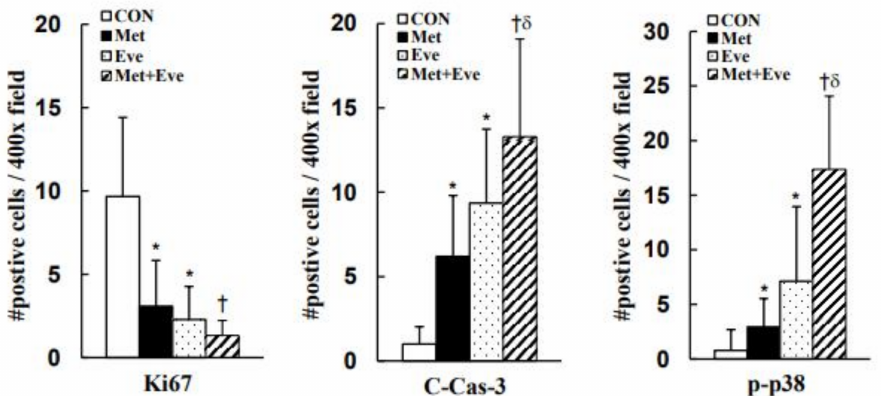
Figure 8. Metformin and everolimus inhibited tumor growth of C33A xenografts in vivo. BALB/c nude mice were subcutaneously injected with C33A cells (1 × 10 7 cells). When the subcutaneous tumor volume reached ~200 mm 3 , metformin (150 mg/kg), everolimus (5 mg/kg), or vehicle control alone (10% DMSO) was intraperitoneally injected every day. ( A ) Schedule of metformin combined with everolimus treatment, ( B ) representative image of a tumor, ( C ) average tumor volume and ( D ) body weight. *, † and δ p < 0.05 compared with CON, Met- or Eve-treated groups. ( E ) Tumor tissue samples were extracted and subjected to HE and immunohistochemical staining to examine the histopathology and expression levels of ki67, cleaved-caspase-3, and p-p38 (shown as brown staining), and quantitative data are presented (H&E, 200 × , bar = 50 µ m; IHC, 400 × , bar = 20 µ m). Values represent the mean ± SD ( n = 4); ** p < 0.01, *** p < 0.001 compared with CON, control. Met, metformin; Eve, everolimus; Comb., metformin combined with